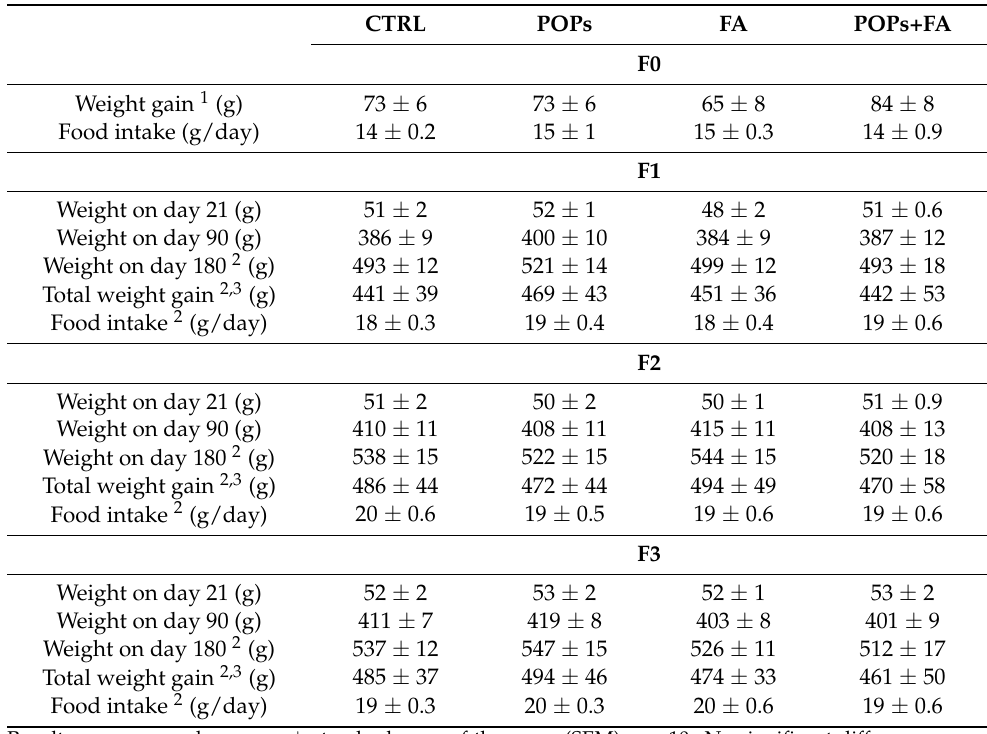
Table 3. Weight gain and food intake of F0 rat dams; body weight of F1, F2, F3 male rats at the ages of 21, 90 and 180 days, total weight gain and food